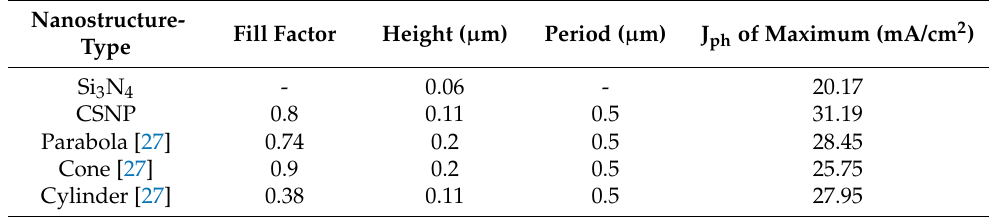
Table 1. Maximum J ph of Nanostructured Solar